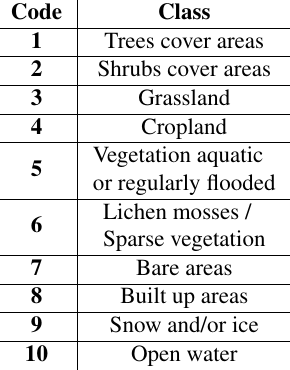
Table 2. CCI Africa Prototype classes